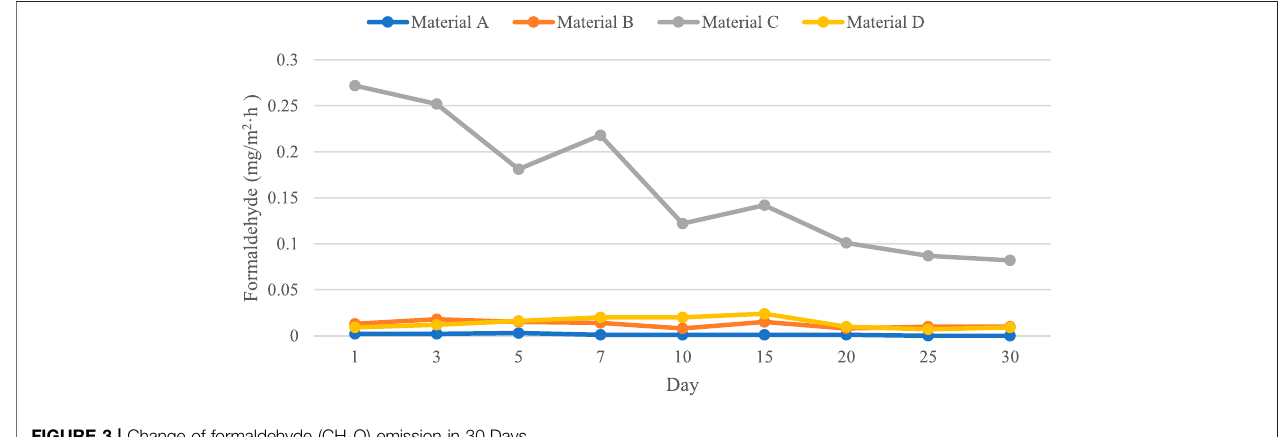
FIGURE 3 | Change of formaldehyde (CH 2 O) emission in 30 Days.